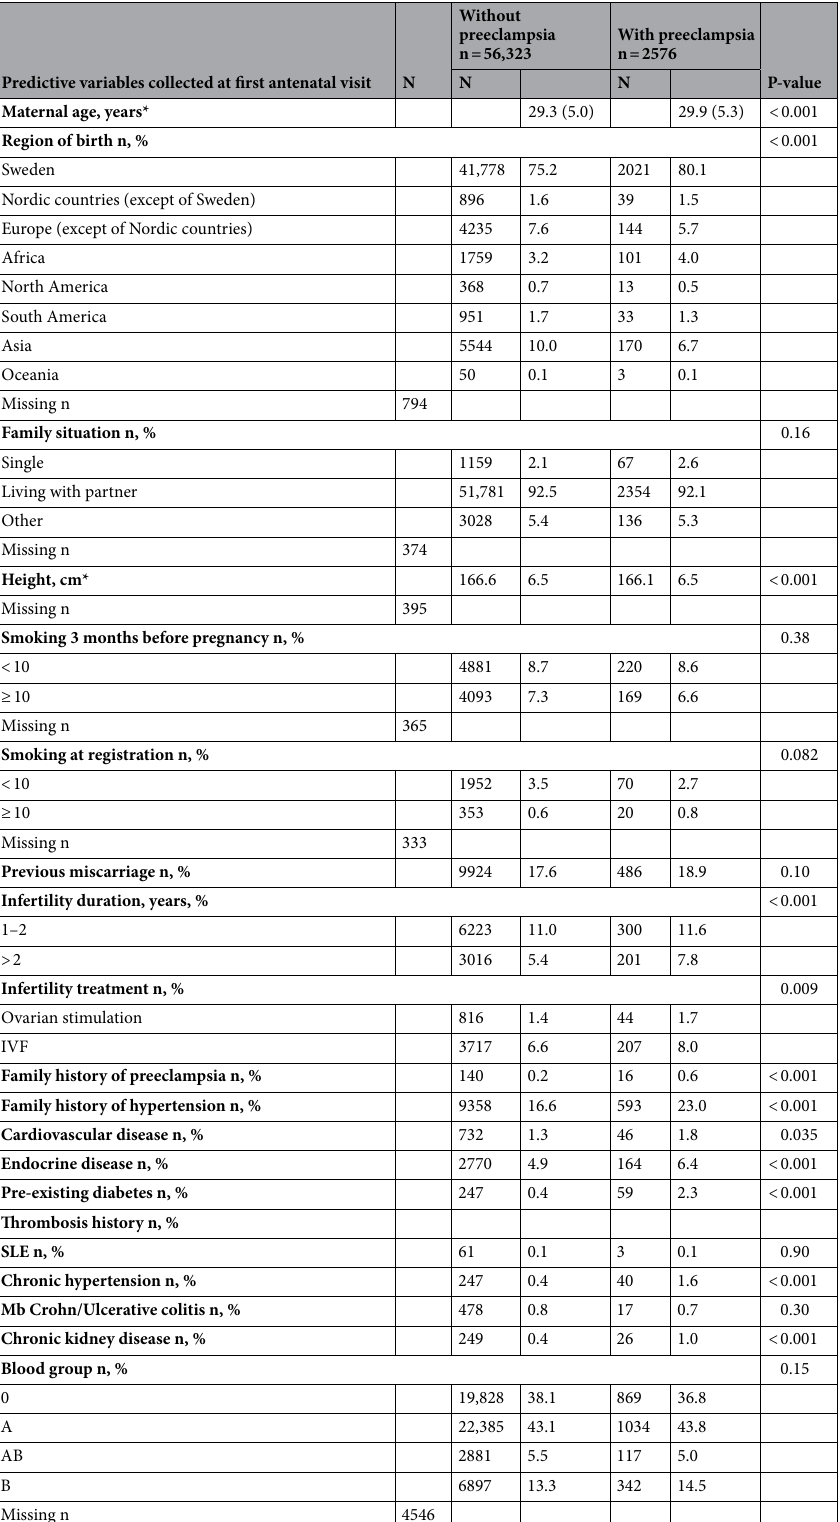
Table 1. Predictive variables routinely collected at first antenatal visit in the study population of 58 899 nulliparous women. *Mean